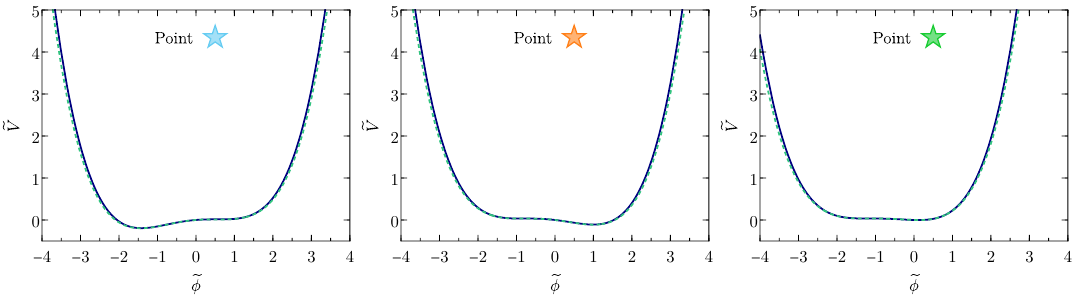
Figure 8 . Comparison of the sum of the zero-temperature potential with either the full ther- mal (A.3) plus Coleman-Weinberg potentials (A.1) (light blue dashed line), or the leading terms in the high-temperature expansion (3.3) (solid blue line). The plots refer to the three points denoted with a star in (cid:12)gure 6 (for which (cid:30) settles respectively in true vacuum, false vacuum and true vacuum after thermal decay) at the temperature e T = e T 0 , with y = 0 : 8 and (cid:21) = 0 : e